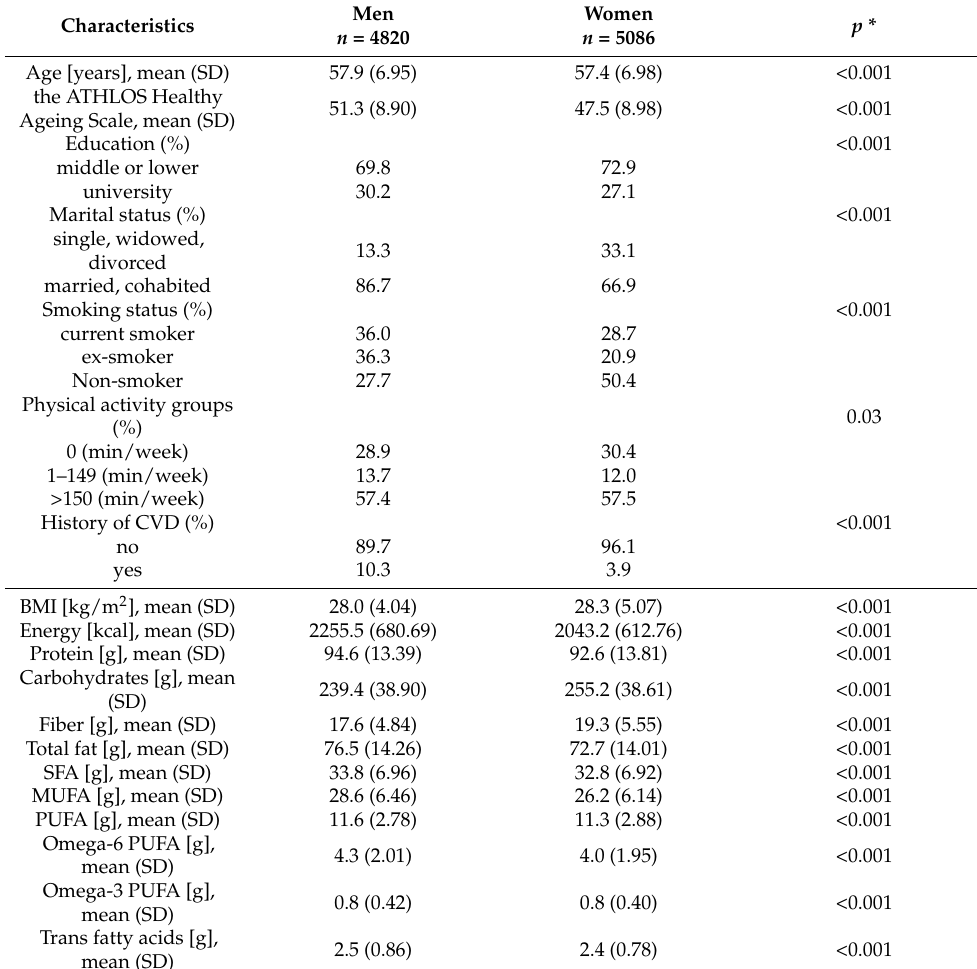
Table 1. Baseline characteristics of participants of the HAPIEE Krakow study by